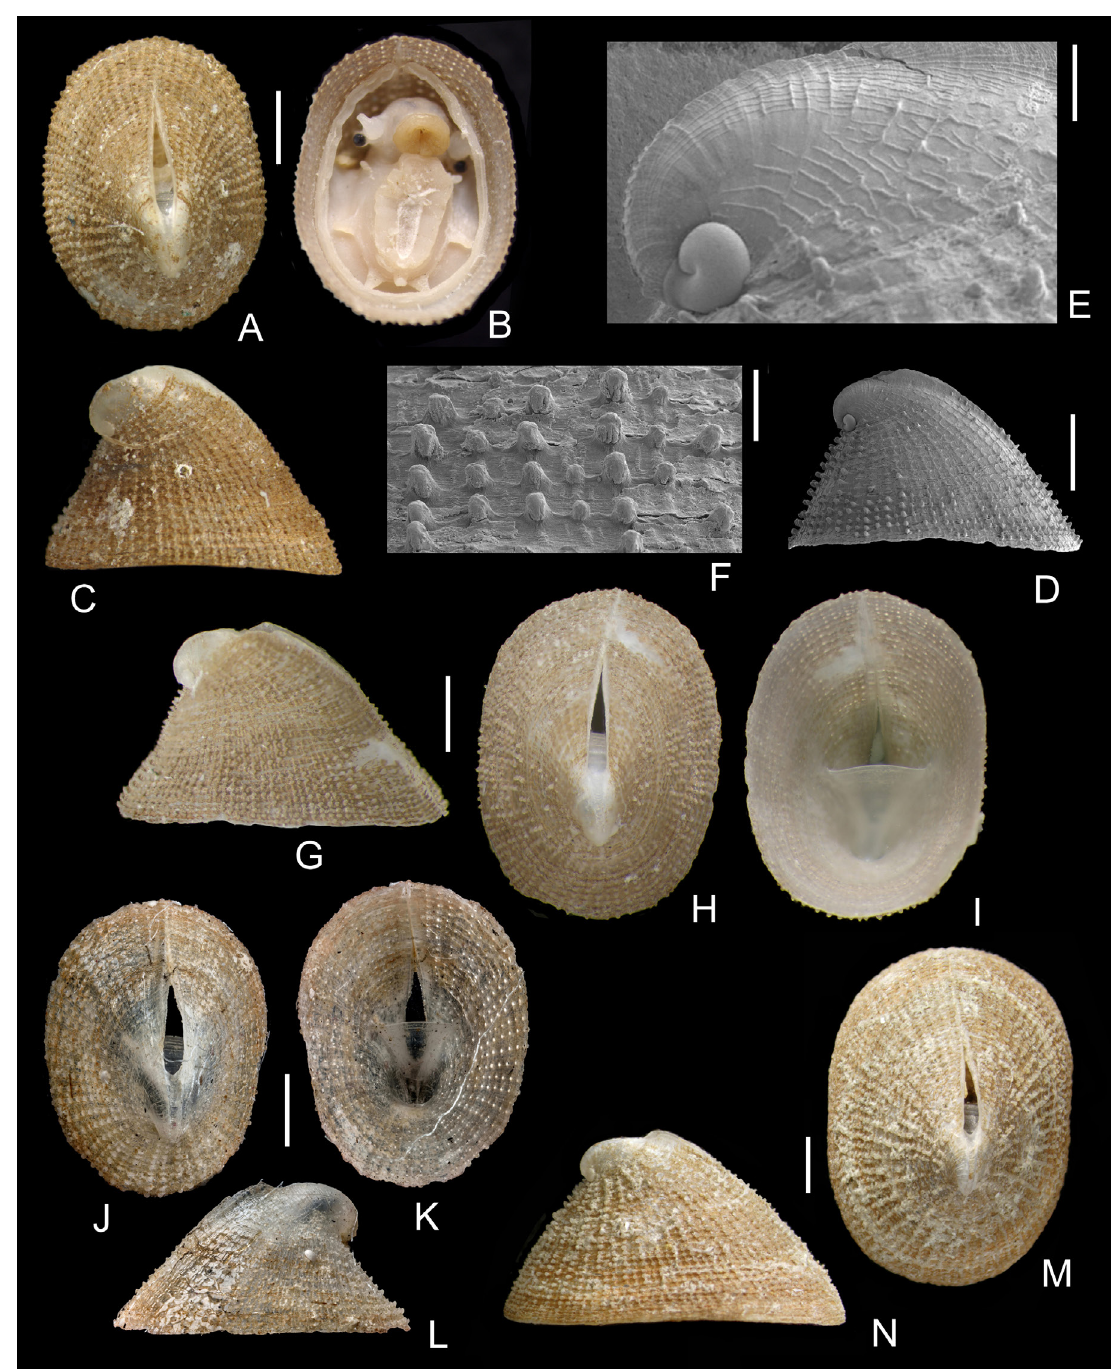
Fig. 5. Fissurellidae 2. Puncturella agger Watson, 1883. A–C . BANGAL 0711, GOC6, 903 m, 4.0 mm. D–F . SEAMOUNT 1, DW116, 985–1000 m, 4.0 mm, SEM micrographs of protoconch and sculpture. G–I . SEAMOUNT 1, DW116, 985–1000 m, 4.4 mm. J–L . Syntype (NHMUK 1887.2.9.130), Challenger expedition, Station 24 (18°38′30″ N, 65°5′30″ W) off Culebra Island, West Indies, 390 fathoms [713 m], 4.1 mm, courtesy and © NHMUK. M–N . Galicia Bank, campaigns 1980‒1981 by Instituto